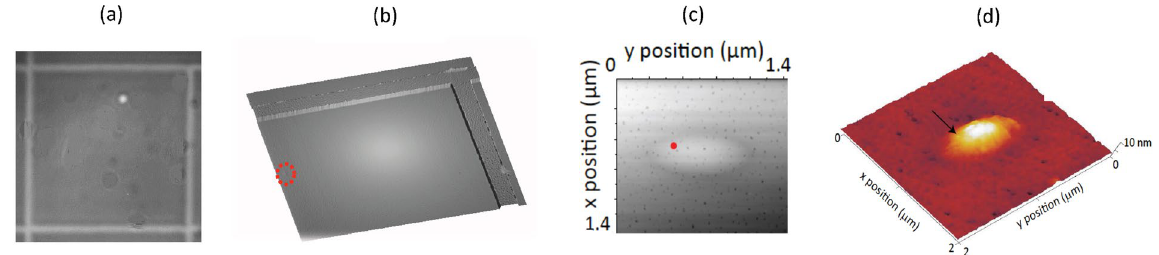
Figure 2. Example of combined photoluminescence and atomic force microscopy to correlate quantum dot location and surface morphological features ( a ) EMCCD image of the photoluminescence from a single QD and reflected light by the alignment marks (metallic crosses), acquired by illuminating the sample simultaneously with both the red and near-infrared LEDs, at a temperature of 4 K. ( b ) Atomic force microscope image of the area between two alignment marks (top right corner of panel (a)). ( c , d ) Atomic force microscope images of a 10 nm-high surface oval defect (found in correspondence to the dashed red circle in panel (b)) on which the position of the QD, measured from the photoluminescence image (red symbol in panel (c) and arrow in panel (d)), is shown. The one standard deviation uncertainty in the position of the QD is estimated to be 17 nm (see main text). [Sample